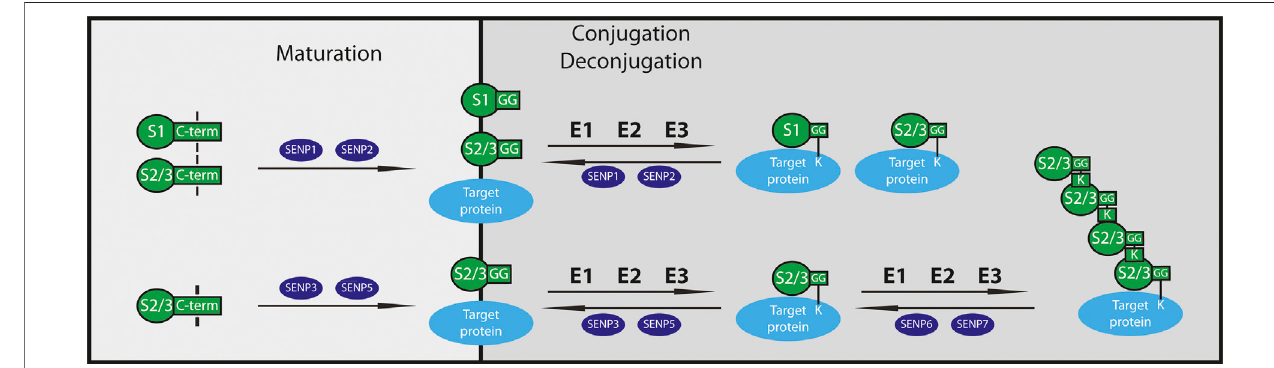
FIGURE1| FunctionofSUMO/Sentrinspeci fi cisopeptidases.SUMOisoformsaresynthetizedasprecursorproteinsandcleavedbySUMO-speci fi cisopeptidases (SENPs). During maturation, SENP1 and SENP2 process both SUMO1 and SUMO2/3, whereas SENP3 and SENP5 hydrolyse only SUMO2/3. Mature SUMO proteins getconjugatedtotargetproteinsthroughanenzymaticcascadesimilartoubiquitinationcatalyzedbyE1,E2andE3enzymesinordertoformmono-orpolySUMOylated substrates. To maintain the equilibrium of SUMOylation and deSUMOylation, SENPs play a crucial role as deconjugases. SENP1 and SENP2 detach SUMO1 and SUMO2/3 from monoSUMOylated substrates, while the SUMO2-speci fi c isopeptidases SENP3 and SENP5 remove SUMO2/3 from targets. SENP6 and SENP7 cut mainly SUMO2/3 from polySUMO2/3-chains of target proteins. S1: SUMO1, S2/3: SUMO2/3, G: Glycine, K: